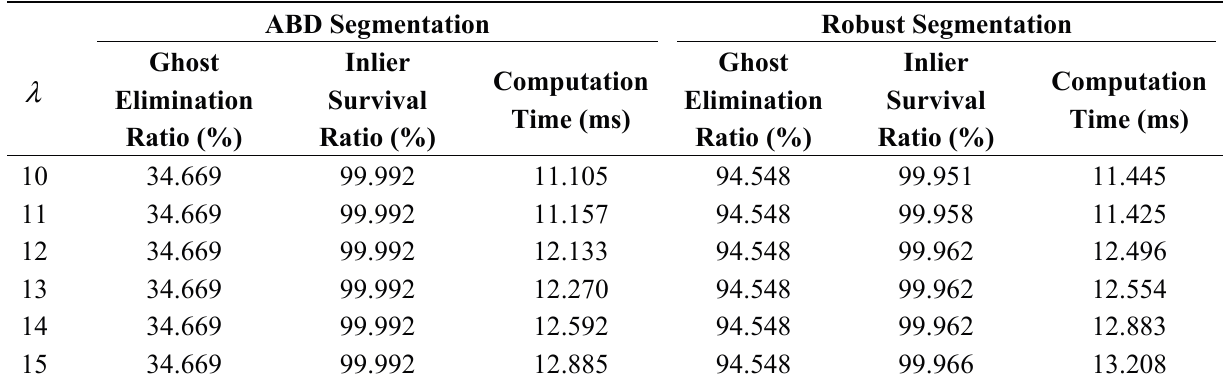
Table 6. Results of ghost elimination in rainy weather.